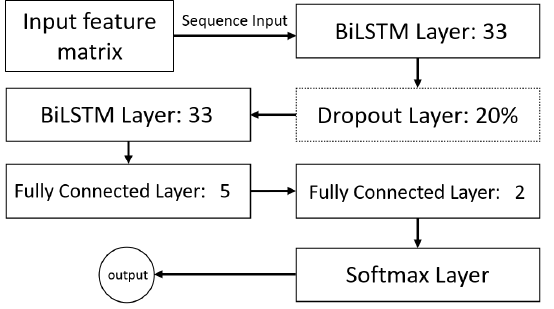
Figure 5. Neural network architecture: the dashed dropout layer is only used in the training